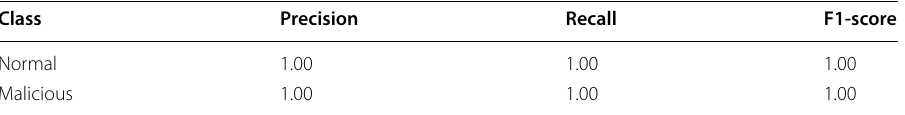
Table 13 Classification report of